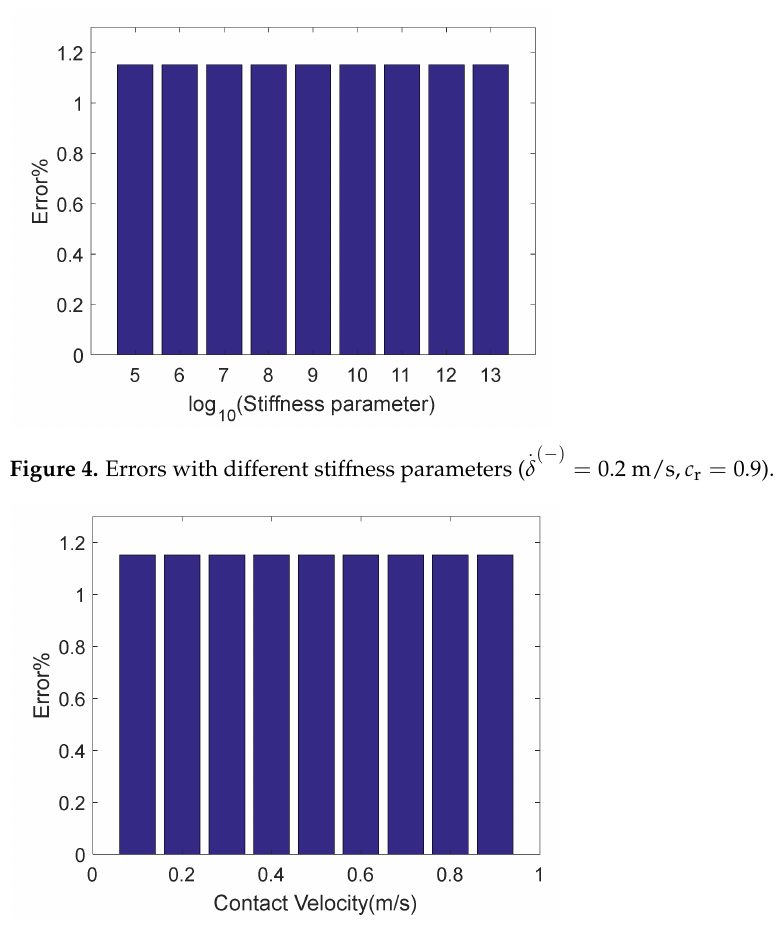
Figure 5. Errors with different initial relative contact velocities ( K = 10 9 N/m 1.5 , c r =